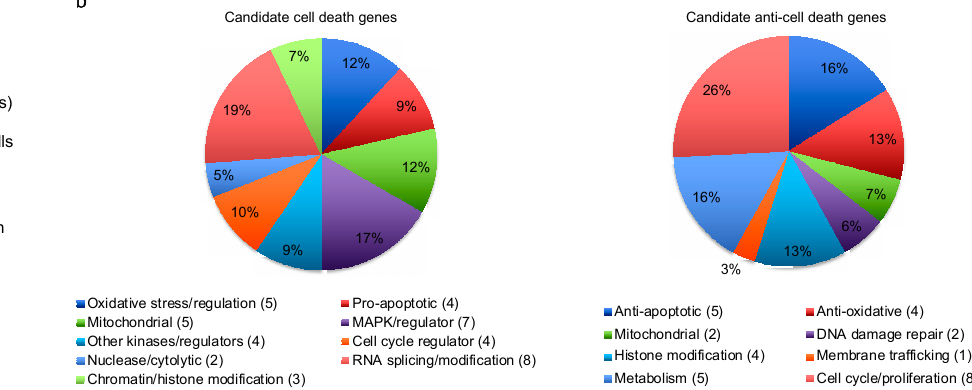
Figure 2. Genome-wide siRNA library screening for caspase-9-independent cell death genes. ( a ) A flow chart for the siRNA library screening of caspase-9-independent cell death genes. JMR cells were transfected with siRNA targeting 21,121 genes individually. ( b ) Pie charts for candidate cell death genes and anti-cell death genes identified after the second round of siRNA library screening. The complete lists of these genes are shown in Tables S1 and